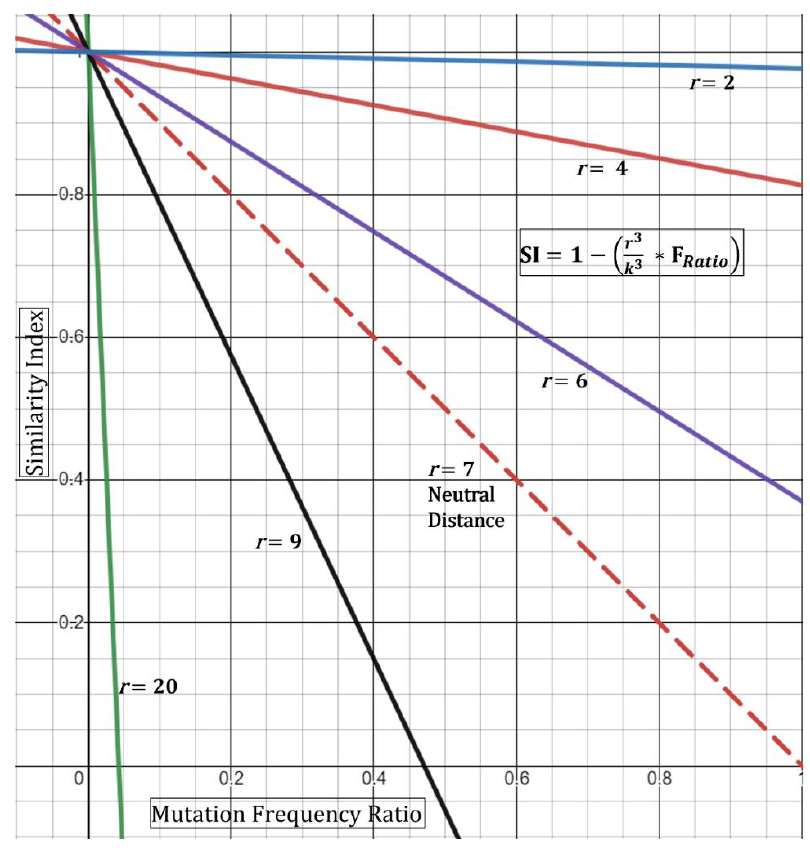
Figure 3. Graphical representation of modified spatial Equation (4). The observed distance/radius, r , of two patients behaves as a tuning knob for the Similarity Index. Close distance encounters ( r < 7) increase the probability (SI) that the two strains are similar.